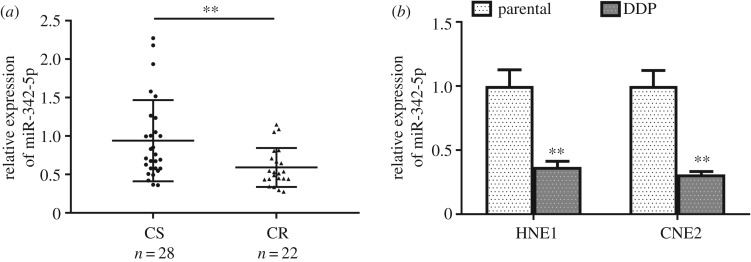
The expression level of miR-342-5p negatively correlates with cisplatin resistance. (a) miR-342-5p expression in NPC specimens from 28 CS patients and 22 cisplatin-resistant (CR) patients. (b) Relative miR-342-5p expression in parental NPC cells and cisplatin-resistant NPC cells. **p < 0.01.